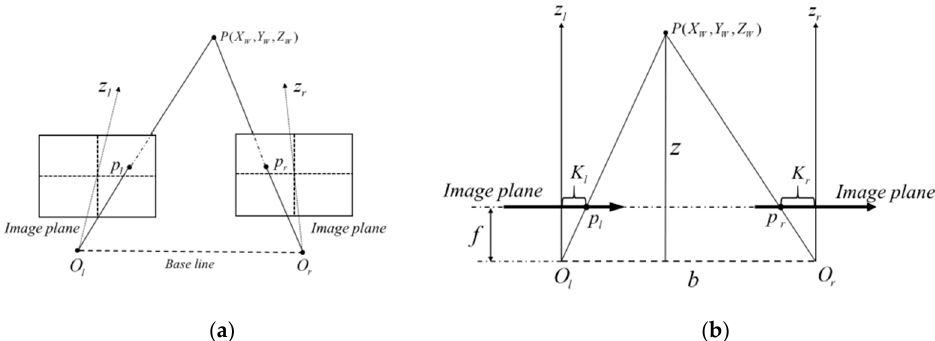
Figure 2. Principle of binocular vision: ( a ) ideal model of binocular vision; ( b ) schematic diagram of parallax calculation.